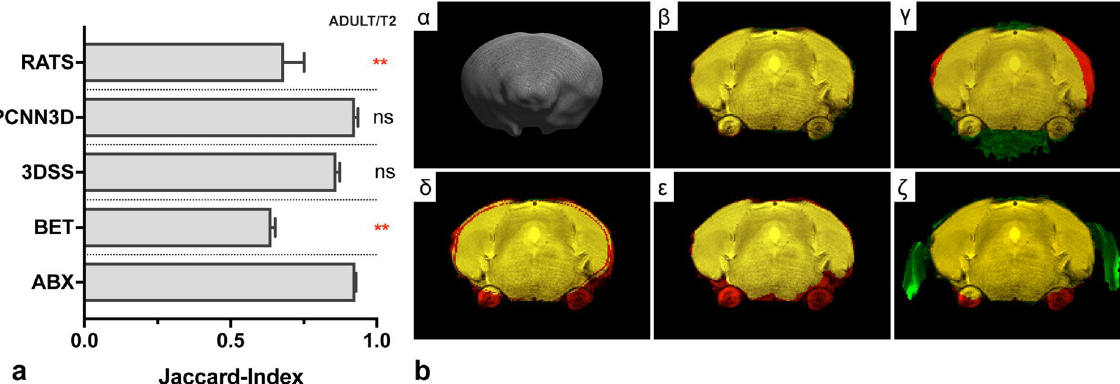
Figure 6. Evaluation with adult (n = 6, T2) mice. First panel (a) presents a bar graph diagram from results of atlasBREX (ABX), Brain-Extraction-Tool v2 (BET), 3dSkullStrip (3DSS), Robust automatic rodent brain extraction using 3-D pulse-coupled neural networks (PCNN3D) and Rapid Automatic Tissue Segmentation (RATS). Results from alternate technical approaches were compared to ABX using Friedman test followed by Dunn’s post-hoc test. ( ** ) p-value < 0.01, (ns) non-significant. Mdn, IQR. Second panel (b) demonstrates results from each method for a representative subject in coronal plane. First image ( α ) shows a 3D surface model computed from the result of ABX. The following images ( β , γ , δ , ε , ζ ) demonstrate the same coronal slice using a three-coloured overlay (yellow colour indicates voxel match, while red (brain tissue erosion) or green (residual non-brain tissue) colour show mismatch) between reference and the respective result from ABX ( β ), BET ( γ ), 3DSS ( δ ), PCNN3D ( ε ) and RATS ( ζ